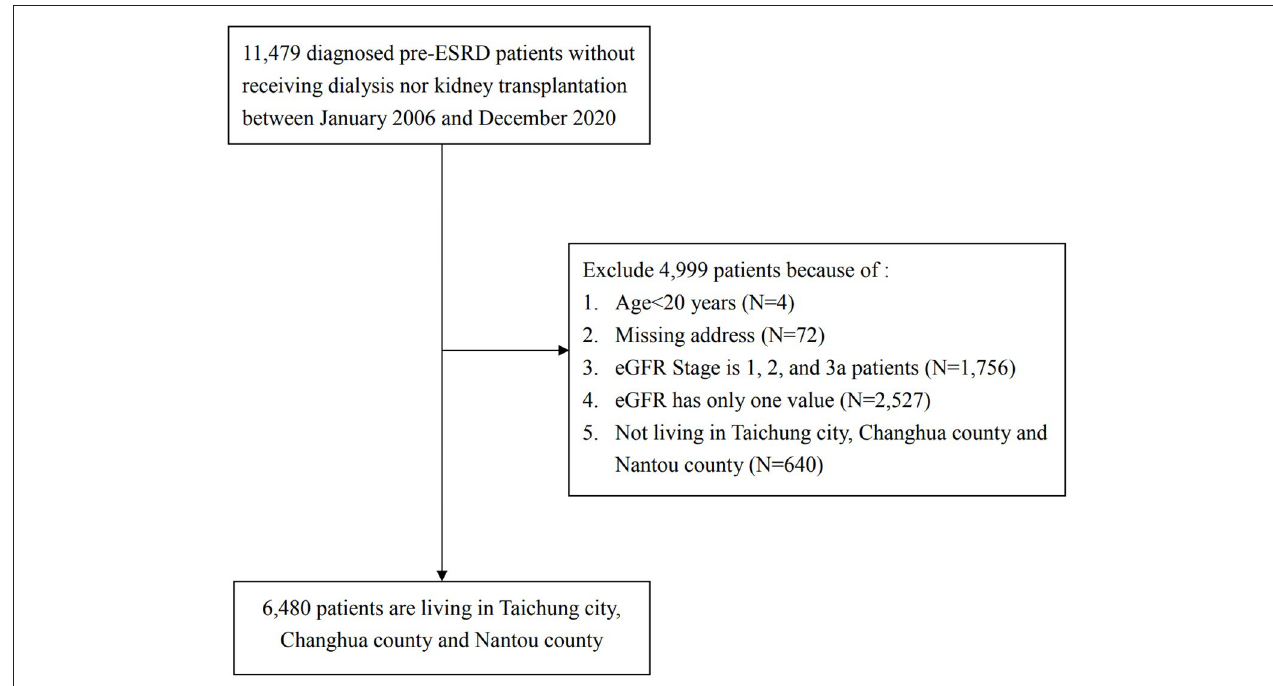
FIGURE 1 | Study flow